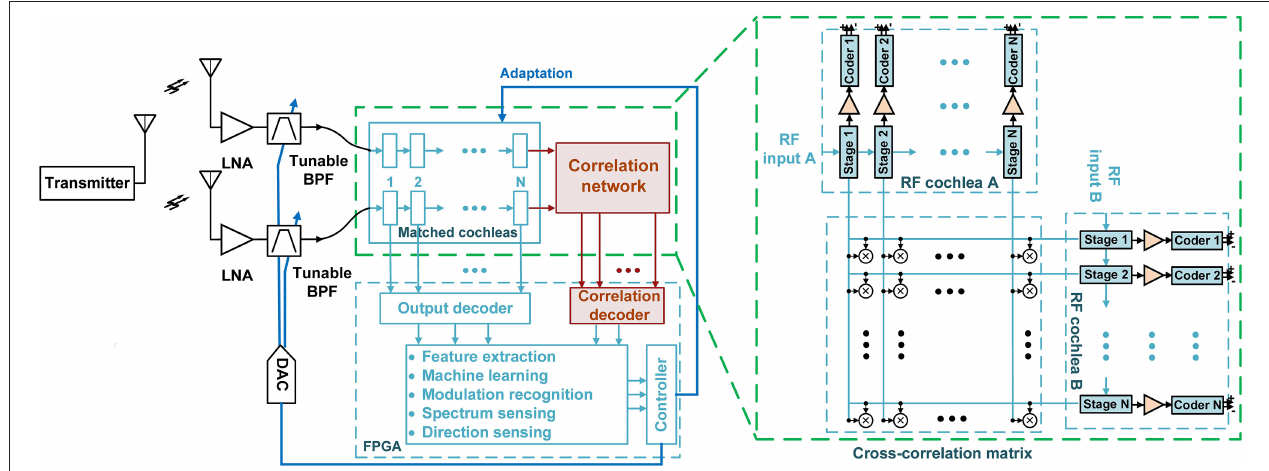
FIGURE 3 | Detailed block diagram of the proposed adaptive radio frequency (RF) scene analysis system. This paper focuses on the highlighted blocks (the correlation network and correlation decoder).